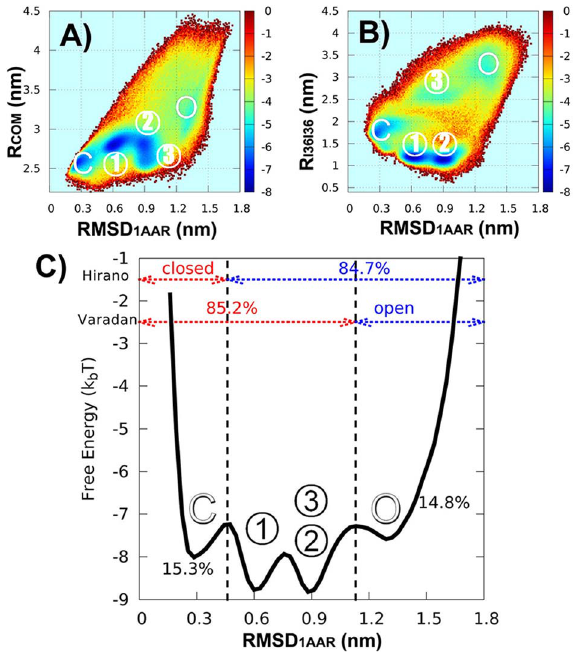
Figure 5. Multi-basin functional landscape of K48-diUb can be used to well reconcile the seemingly contradictory experimen- tal measurements of the conformational equilibrium. (A) Free energy profile as a function of R COM and RMSD from the X-ray structure of the closed form of diUb ( RMSD 1 AAR ). (B) Free energy profile as a function of the distance between I36 hydrophobic patches ( RMSD I 36 I 36 ) and RMSD 1 AAR . Beside the closed and open basins (labeled by O and C), there are three intermediate basins (labeled by 1, 2, 3) on the free energy surface of K48-diUb. (C) Free energy profile as a function of RMSD 1 AAR . Intermediate states 2 and 3 are indistinguish- able in the one-dimensional free energy profile. Open and closed populations are 15 : 3% , and 14 : 8% , respectively. The remaining conformational space is mainly consisting of three intermediate states whose population is about